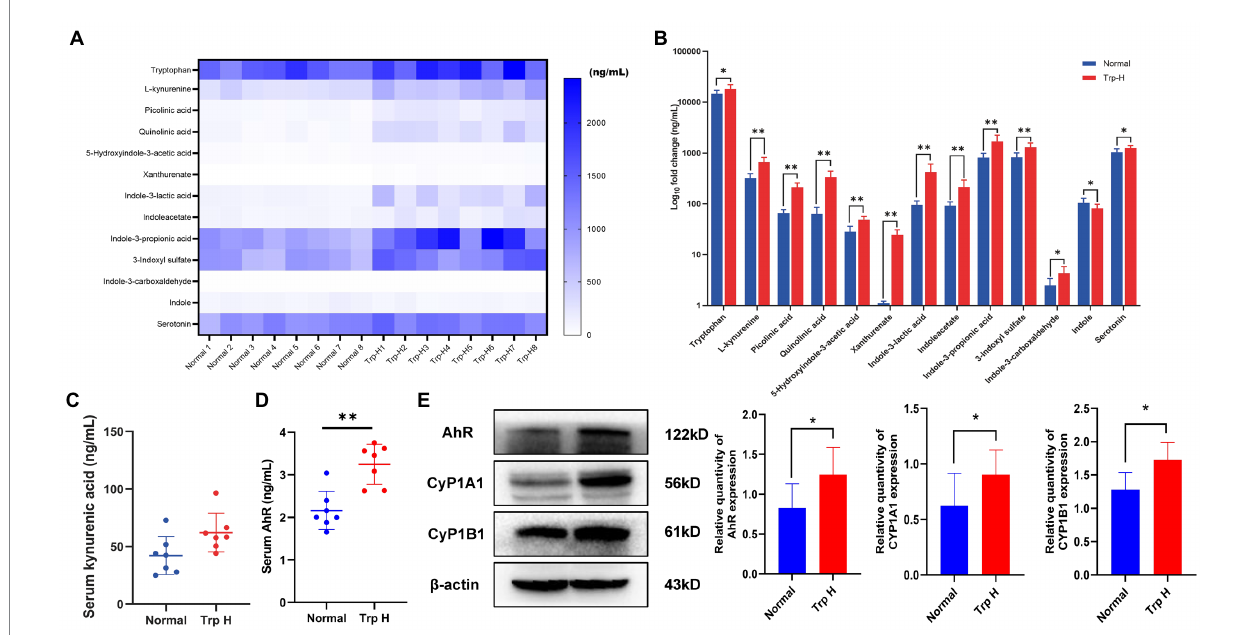
FIGURE 3 Dietary tryptophan induced tryptophan metabolites accumulation and activation of AhR pathway. (A,B) The levels of tryptophan metabolites in serum ( n = 8). (C) Serum kynurenic acid ( n = 8). (D) Serum AhR ( n = 7). (E) Western-blot analysis of AhR, CyP1A1, CyP1B1 expression in kidney tissue of rat with or without tryptophan diet ( n = 8). The data are presented as the mean + standard deviation (* p < 0.05, ** p <